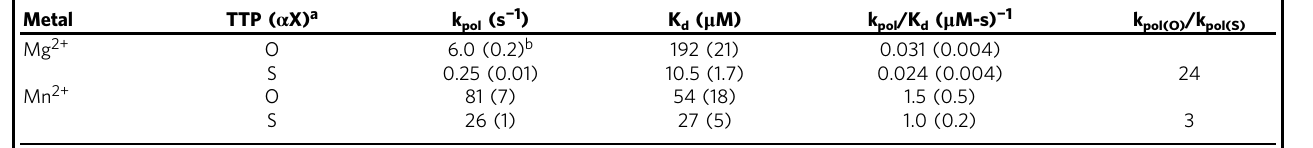
Table 1 Summary of single turnover kinetic parameters